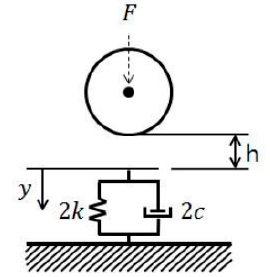
Figure 2. Dynamic model representing the impact on the track by the floating wheel.